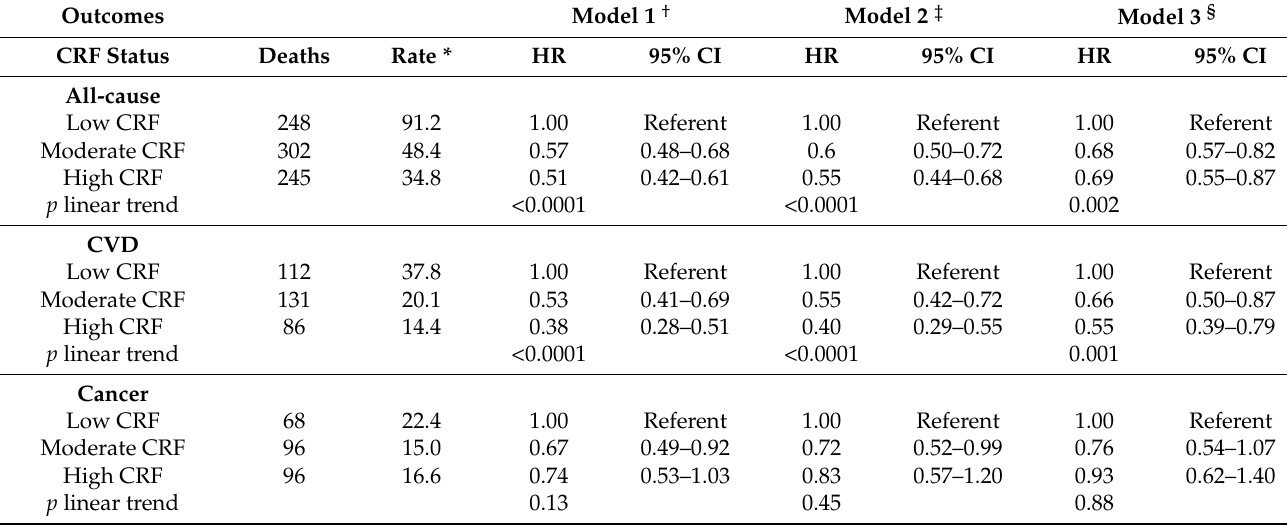
Table 2. Rates and hazard ratios for mortality by CRF groups in men with